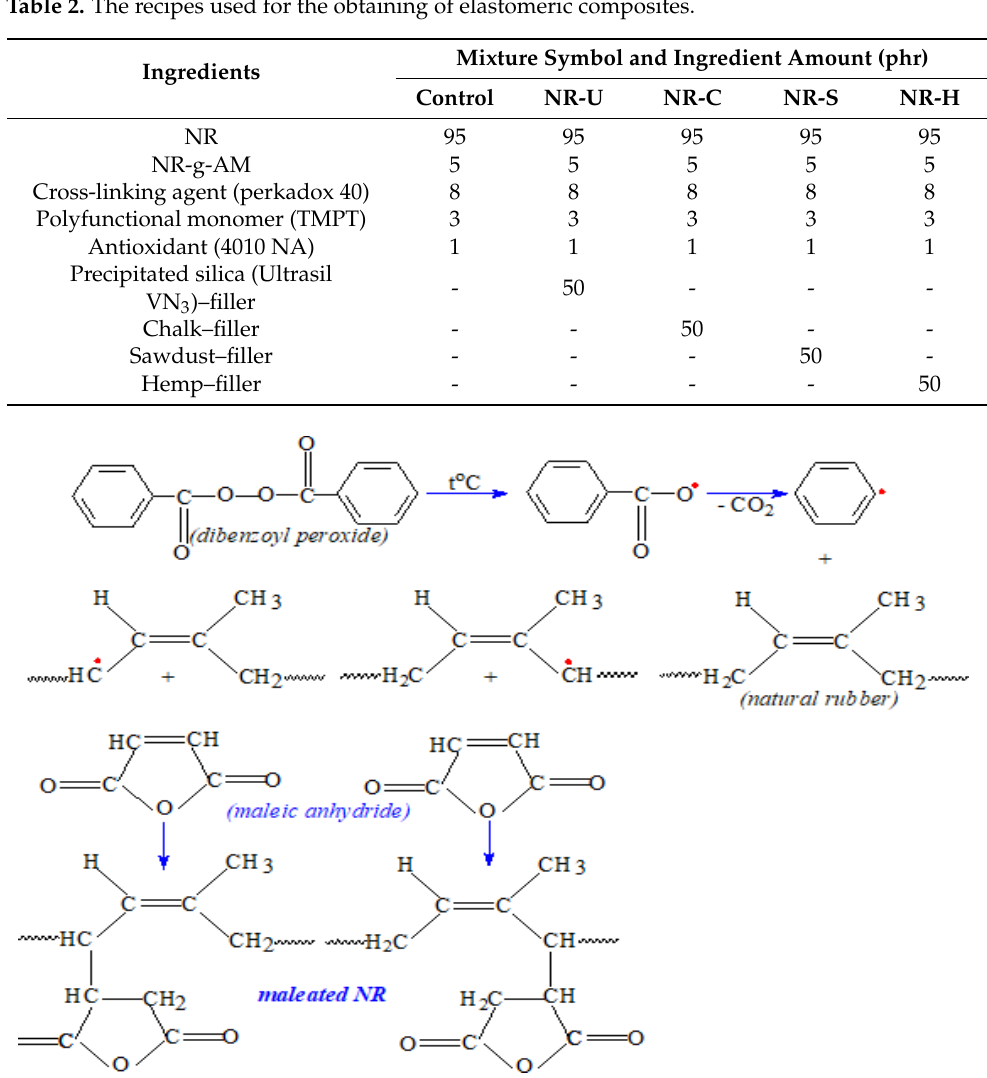
Table 2. The recipes used for the obtaining of elastomeric composites. Ingredients